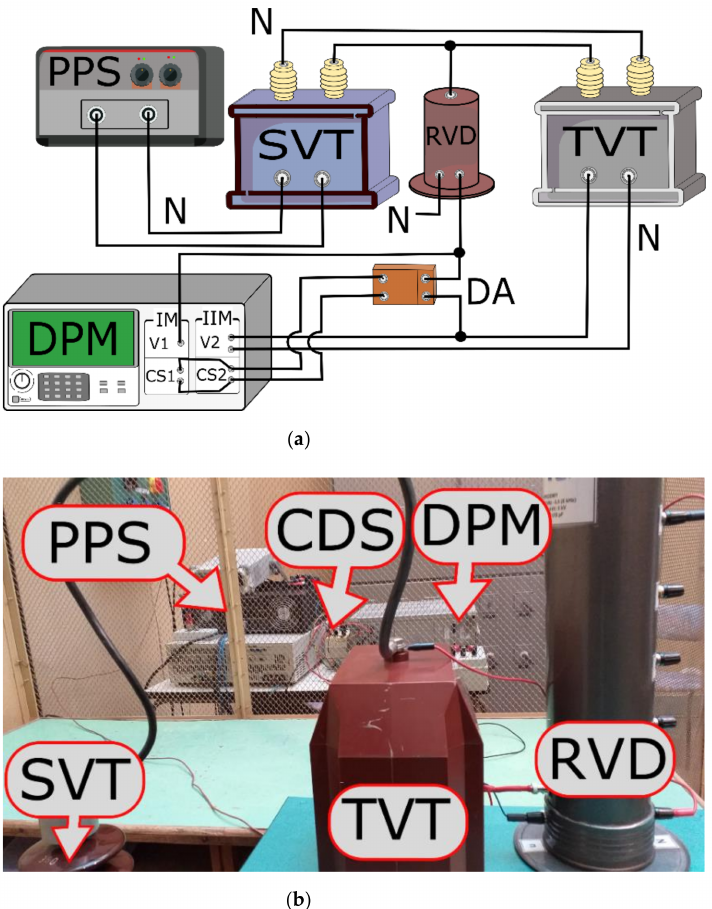
Figure 4. The measuring system used to determine the transformation accuracy of harmonics of distorted primary voltage: ( a ) block diagram, and ( b ) photo of the test